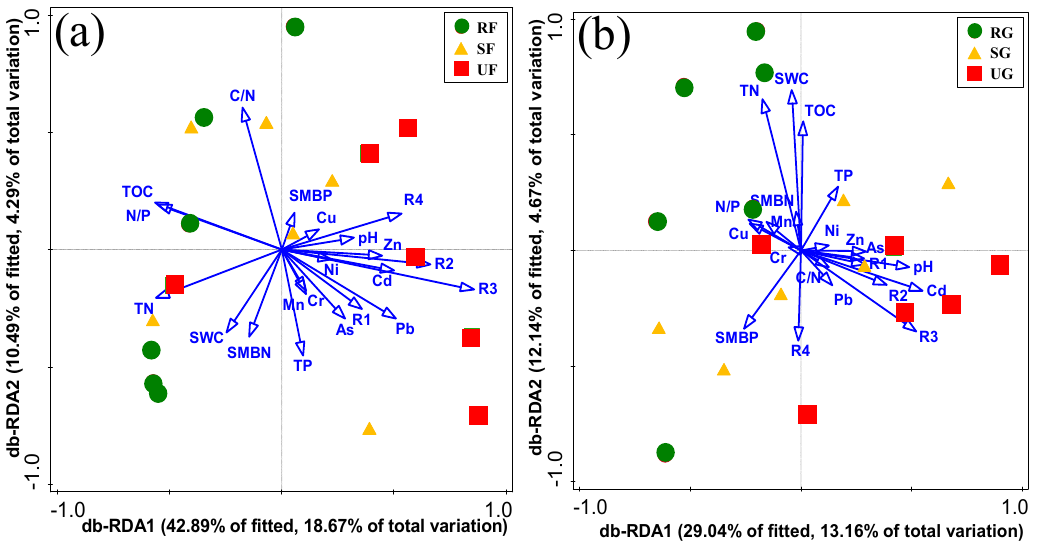
Figure 4. Distance based redundancy analysis (db-RDA) showing the relationships between bacterial communities and environmental factors in forestland ( a ) and grassland ( b ) at the OTU level. RF, SF, UF, RG, SG and UG represent rural forestland, suburban forestland, urban forestland, rural grassland, suburban grassland and urban grassland, respectively.